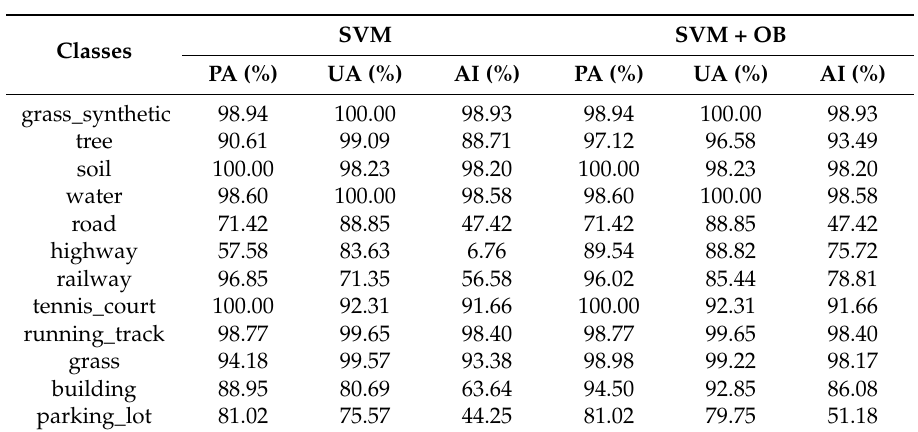
Table 3. Classification results at the class level using SVM and SVM + OB classifiers. PA, producer’s accuracy; UA, user’s accuracy; AI, accuracy